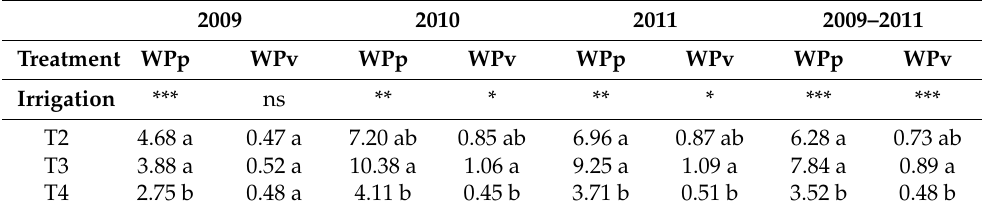
Table 8. Water productivity of vegetation (WPv) and production (WPp) of the different high load irrigation treatments, corresponding to the years 2009, 2010, and 2011.